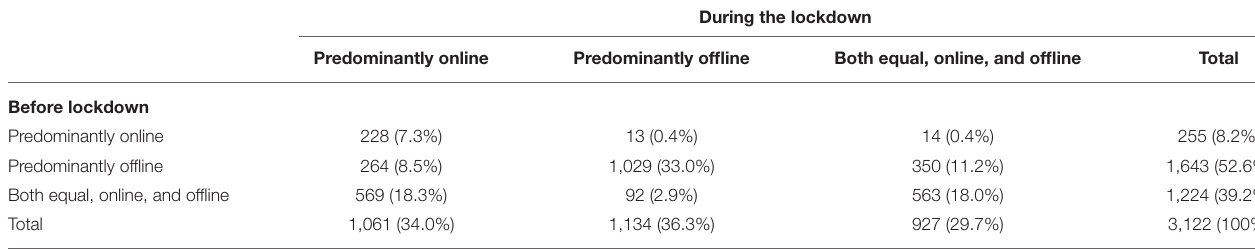
TABLE 3 | Distribution of preferred shopping before and during the lockdown ( N = 3,122).